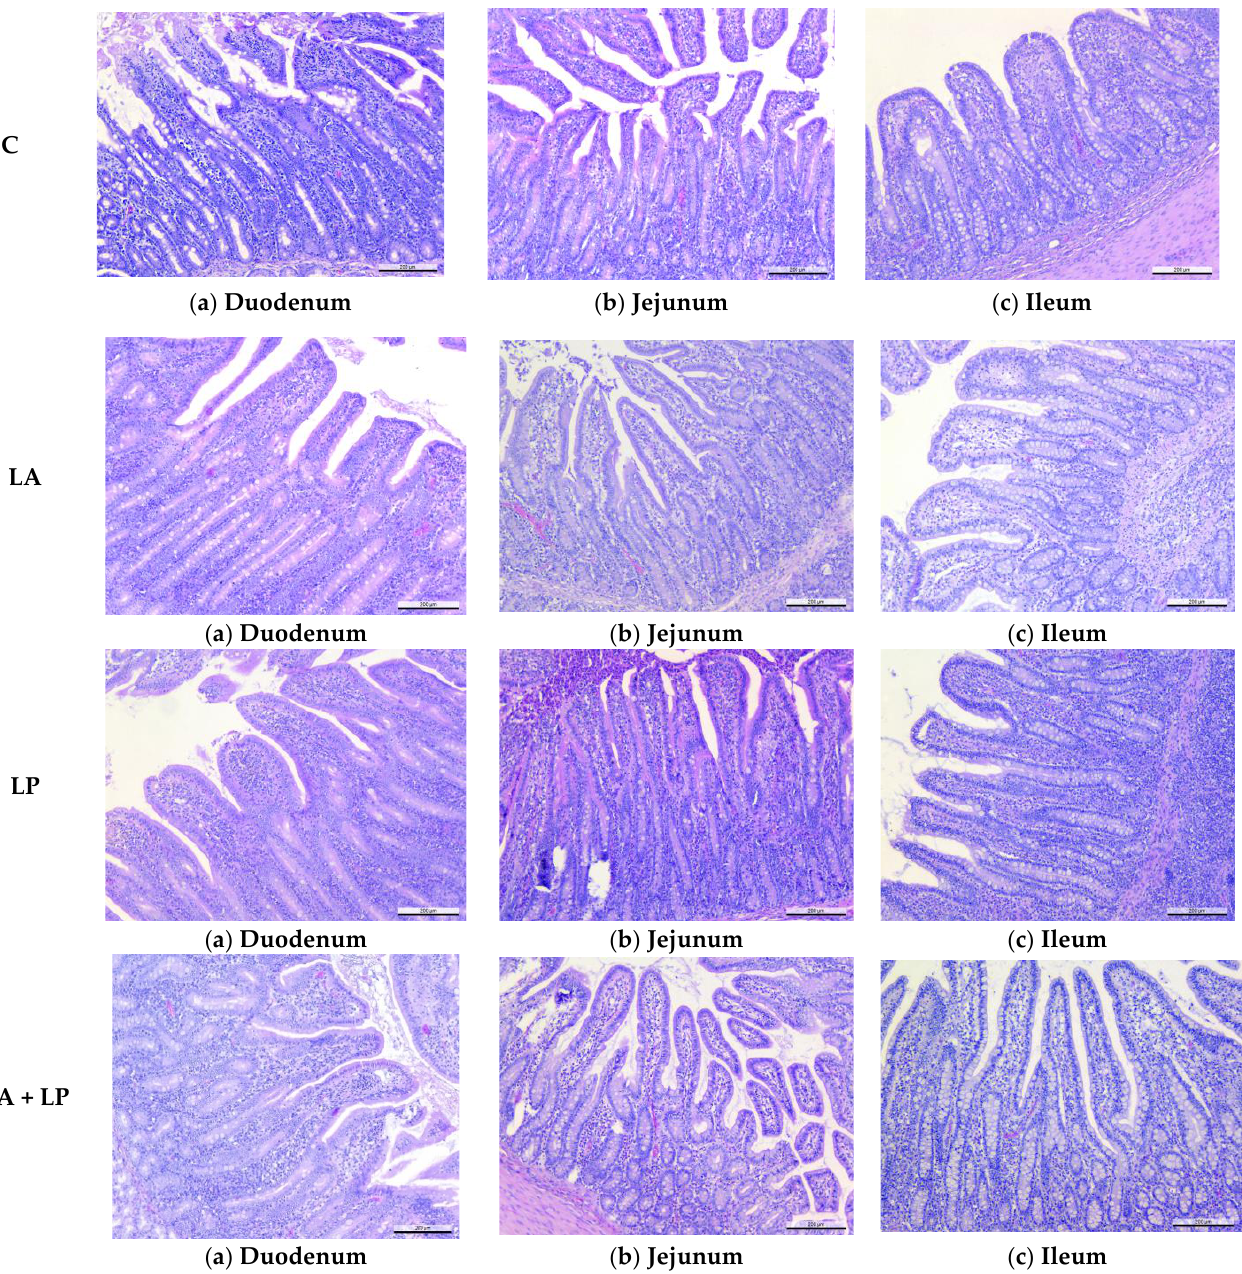
Figure 2. The intestinal morphometric appearances of the duodenum ( a ), jejunum ( b ) and ileum ( c ) of the weaned piglets (n = 8/group). The scale bars in each image indicate 200 μm. Villus height was measured from the tip of the villus to the crypt-villus junction and the crypt depth was measured from the crypt-villus junction to the base of the crypt. C — control diet; LA — control diet supplemented with microencapsulated L. acidophilus; LP — control diet supplemented with microencapsulated L. plantarum ; LA + LP — control diet supplemented with microencapsulated L. acidophilus and L. plantarum .